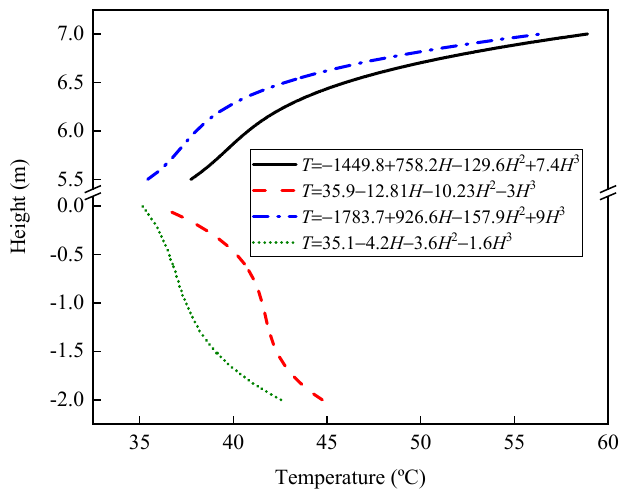
Figure 14. Fitted curves of temperature gradients of the surfaces B and C in summer. For engineering application, a simplified critical temperature gradient in summer with a regular water level (5.05 m) is provided in Figure 15. This temperature gradient is also obtained at 2 p.m. when the ambient air temperature is 30 °C. The temperature gra- dient is the increment over the ambient air temperature. Figure 15. Simplified temperature gradient under the full-water condition in summer. Several key points on different surfaces are selected to show the temperature changes over 72 h in winter, as illustrated in Figures 16 and 17. These points have the same defini- tions as those in Figure 11.